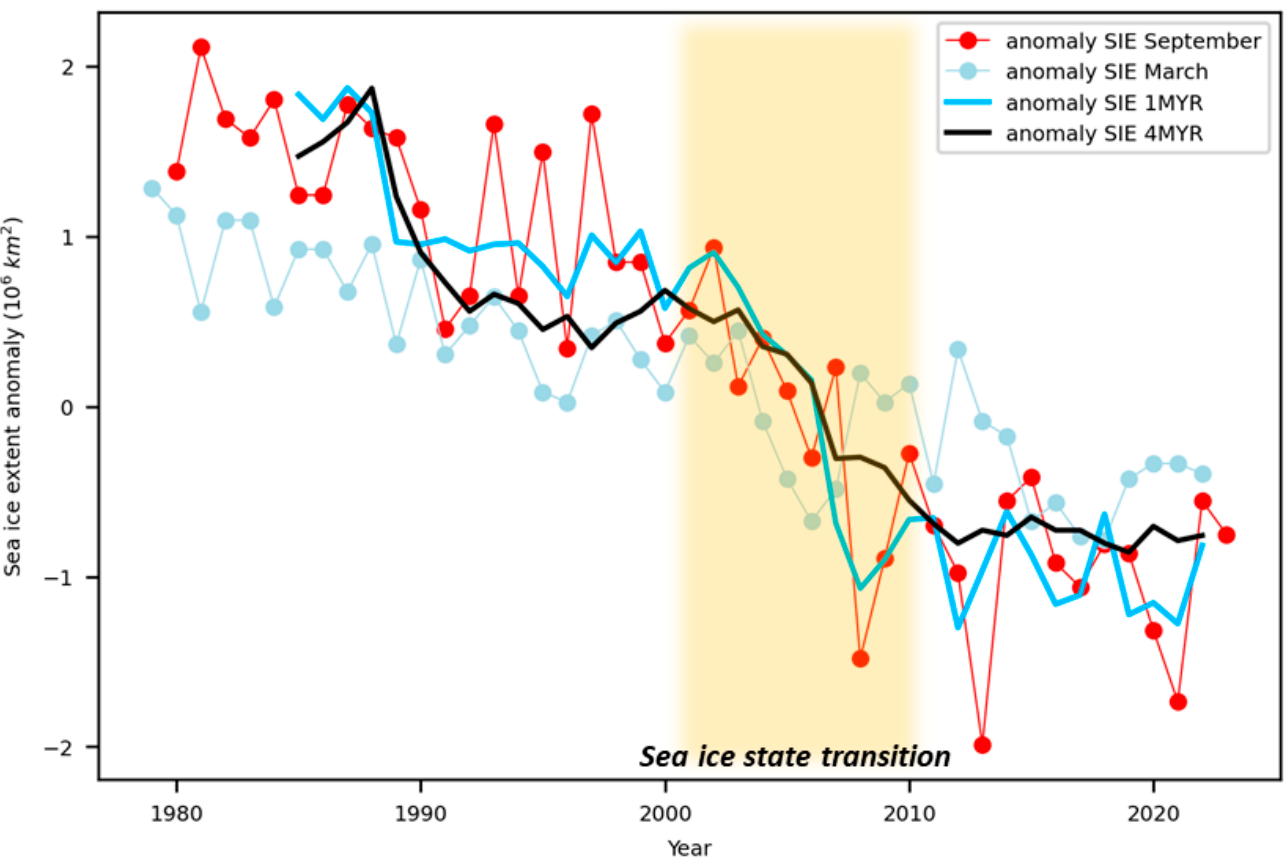
Figure 5. Changes in the Arctic sea ice extent (SIE). The total September and March SIE anomalies are taken from the OSI SAF Sea Ice Index v2.1 (available at https://osisaf-hl.met.no/v2p1-sea-ice-index, accessed on 5 January 2023) [80]; the reference period is 1989–2021. All data are based on passive microwave sensors (the SMMR, SSM/I, and SSMIS); the multiyear (older than one year, 1MYR) and old (older than 4 years, 4MYR) SIE anomalies are taken from NSIDC [112], see more details in [43]. SIE is defined as the area covered with more than 15% of sea ice.